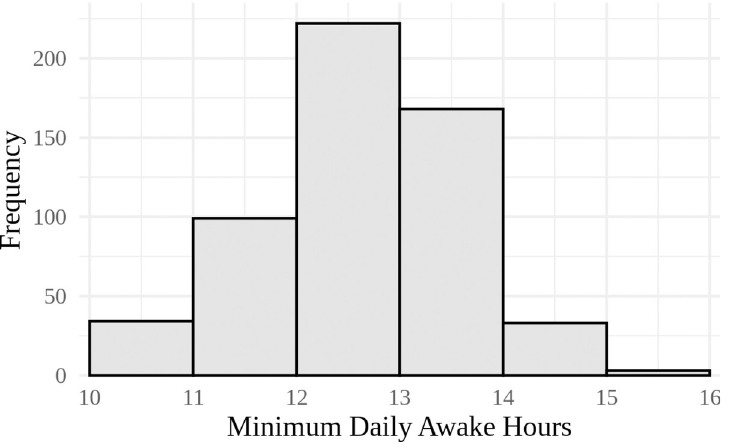
Fig 2. Histogram of minimum daily awake hours per child (n =